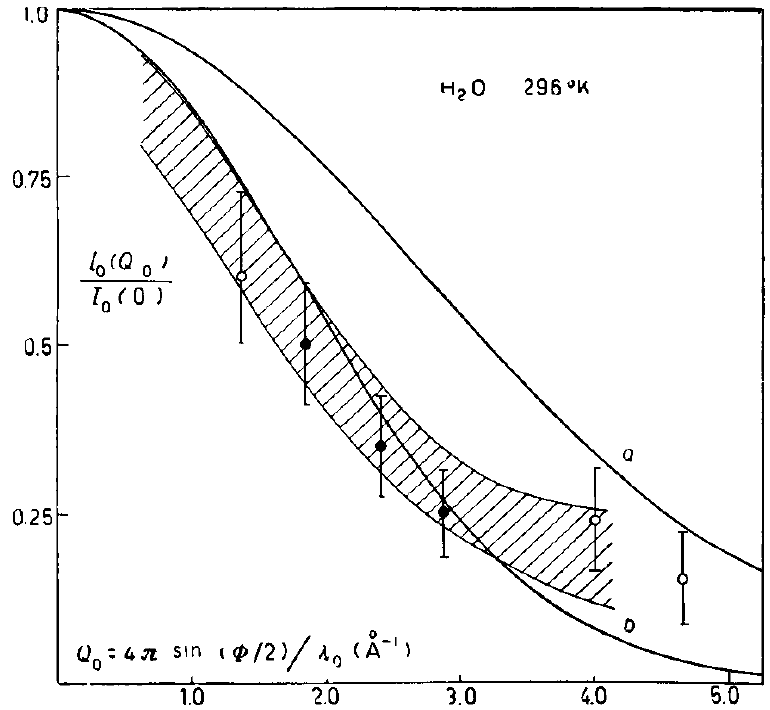
Figure 14. The form factor of the thermal cloud for the protons in H 2 O at room temperature. The filled circles are obtained from patterns for which there is a fairly clear separation of “nearly-elastic “and inelastic” components and the open circles where the curves had to be fitted. The upper solid curve represents a Debye-Waller factor with <u>, the average amplitude of oscillation, of about 0.26 Å applicable to ice at room temperature while the lower solid curve is a fit of a Debye-Waller factor to the measurements for which <u> is about 0.4 Å. The shaded region is taken from a separate experiment where only the nearly elastic scattering was measured. This figure is taken from Figure 13 of ref. [46] courtesy of Nuovo Cimento.